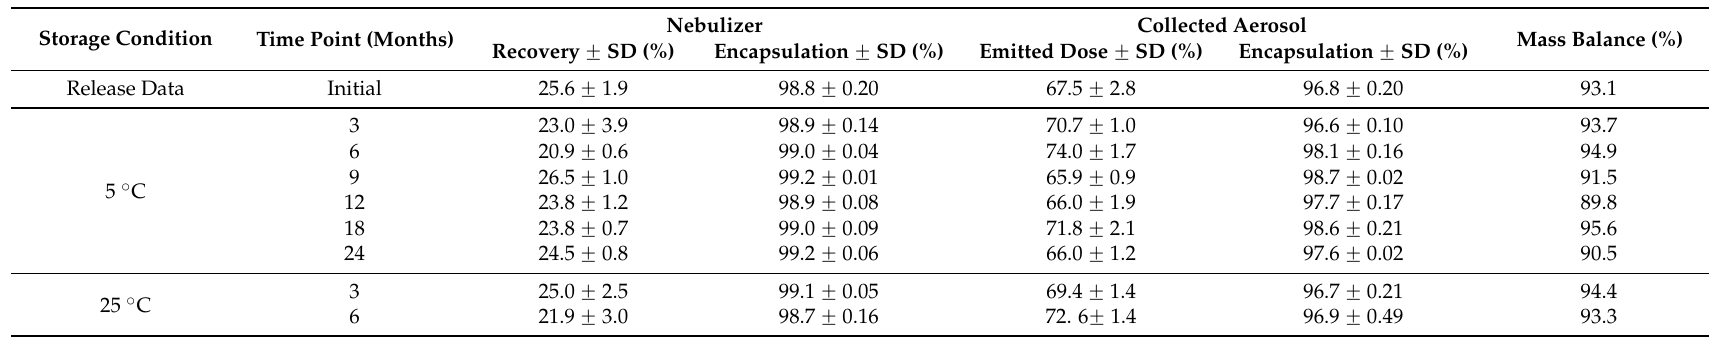
Table 1. The aerosol integrity of the first GMP batch of Lipoquin was verified over two-year refrigerated storage and six-month room temperature storage. Reprinted with permission from [41]. Copyright 2010 RDD online.